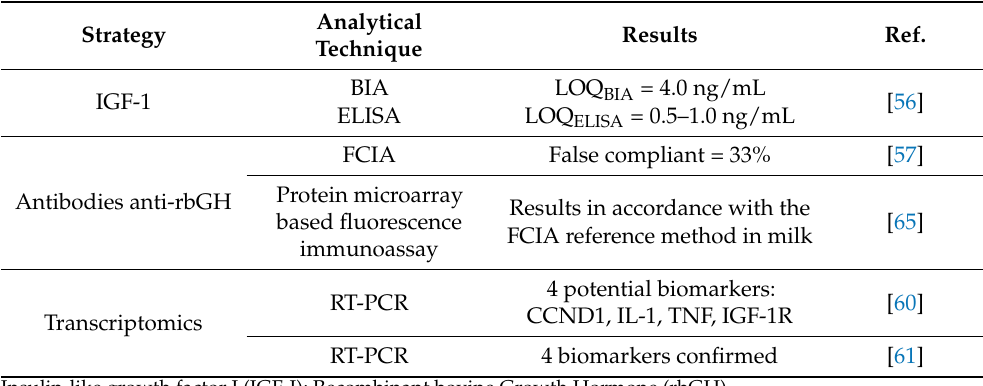
Table 3. Indirect analytical strategies in milk to detect rbGH